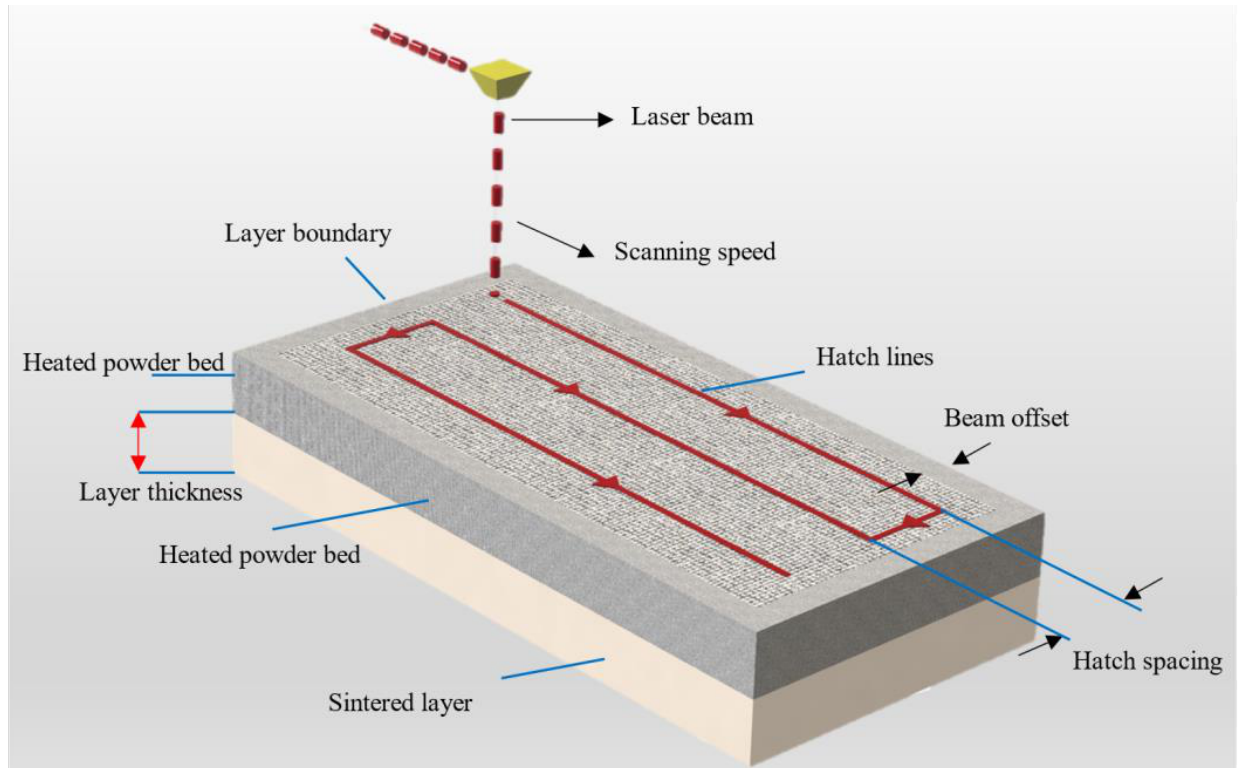
Figure 4. Process parameters for SLS printing, redrawn from [105].